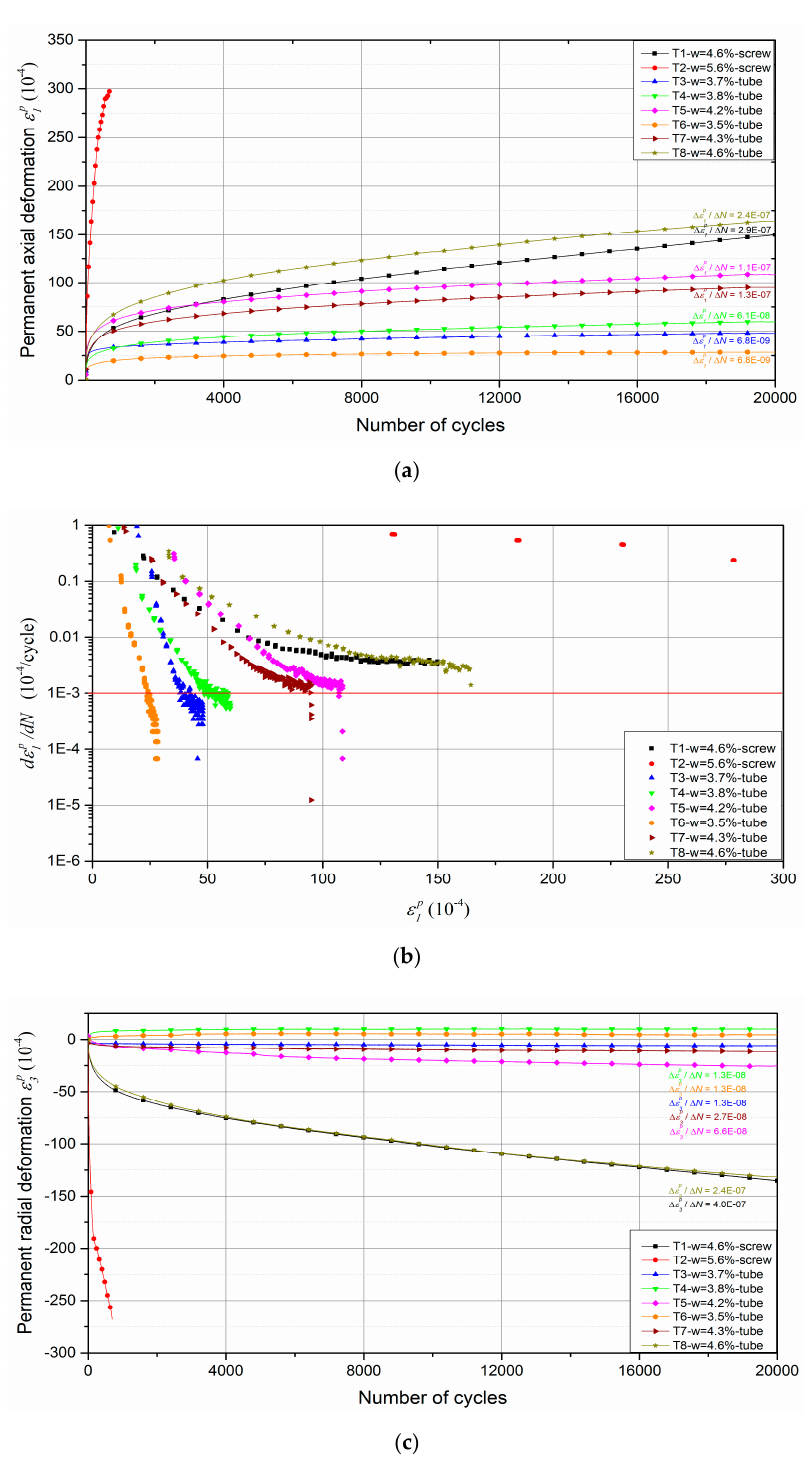
Figure 12. Permanent deformation behaviour: ( a ) Permanent axial deformation versus number of cycles; ( b ) Permanent axial deformation rate versus the accumulated permanent axial deformation; ( c ) Permanent radial deformation versus number of